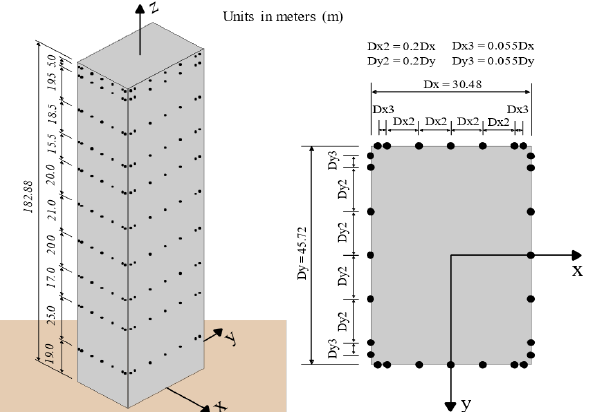
Figure 2. CAARC standard full-scale tall building and positions of the pressure plug indicators (adapted from